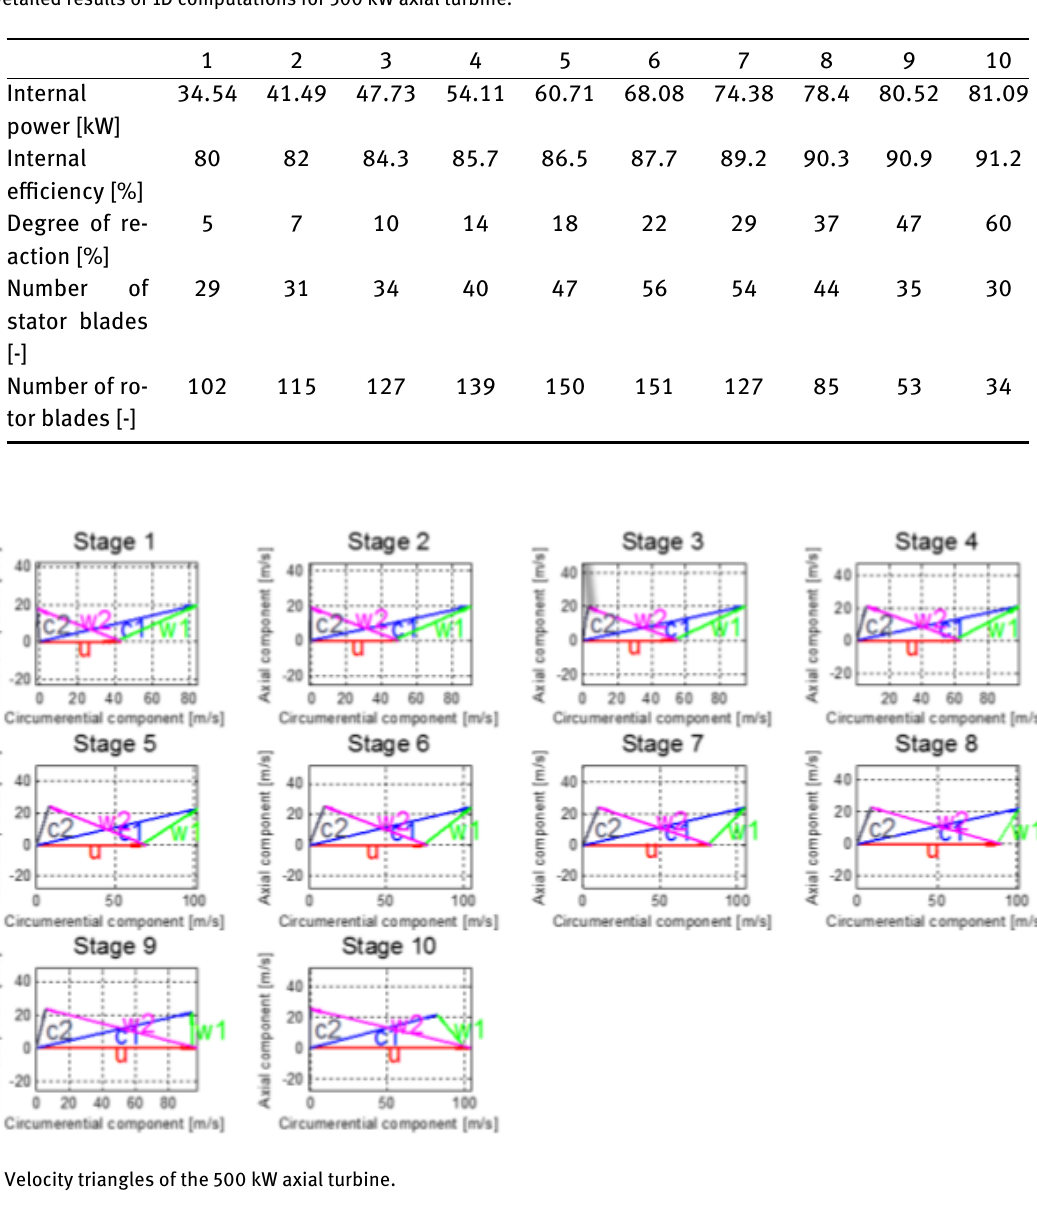
Table 8: Detailed results of 1D computations for 500 kW axial turbine.